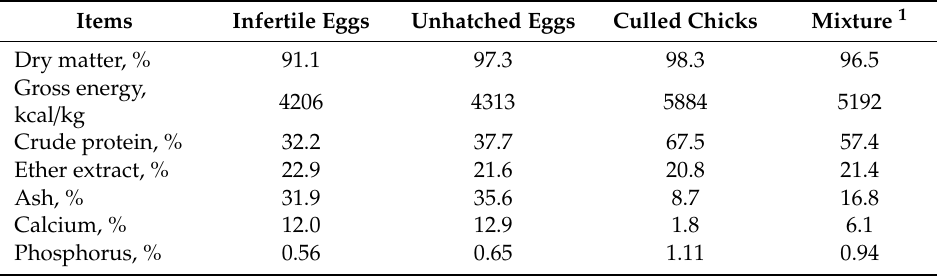
Table 3. Analyzed composition of hatchery byproducts (as-is